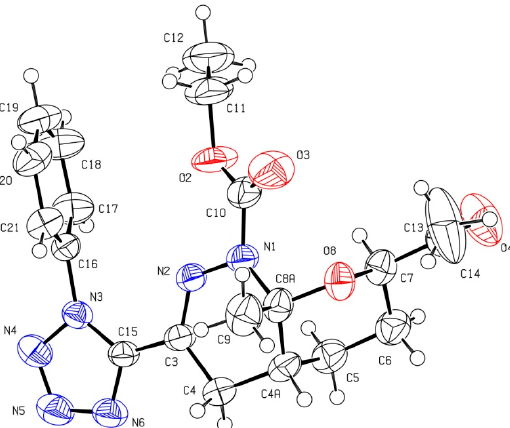
Figure 1. ORTEP-3 diagram of compound 7 with anisotropic displacement ellipsoids drawn at the 50% probability level. The methyl groups at C12 and C14 are disordered over two alternate positions; for clarity, only one of these positions is shown.